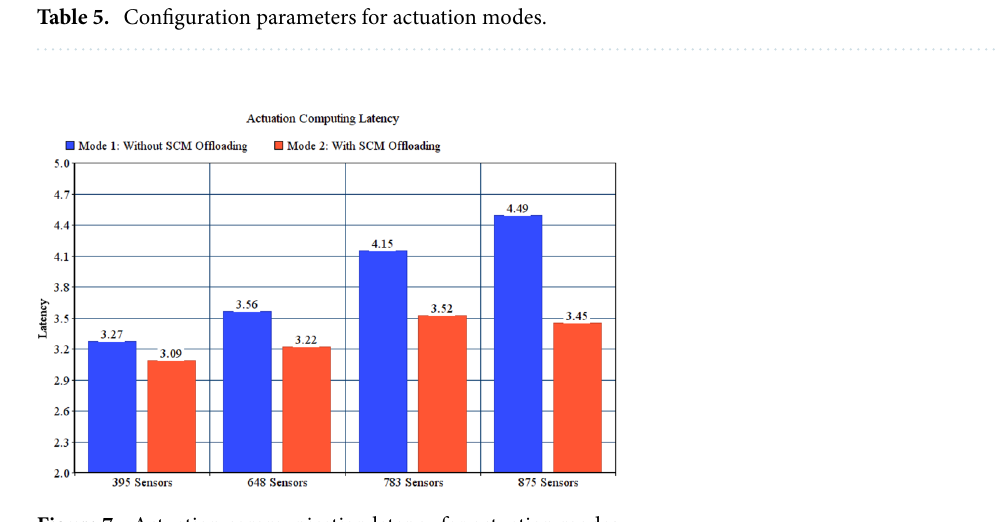
Figure 7. Actuation communication latency for actuation